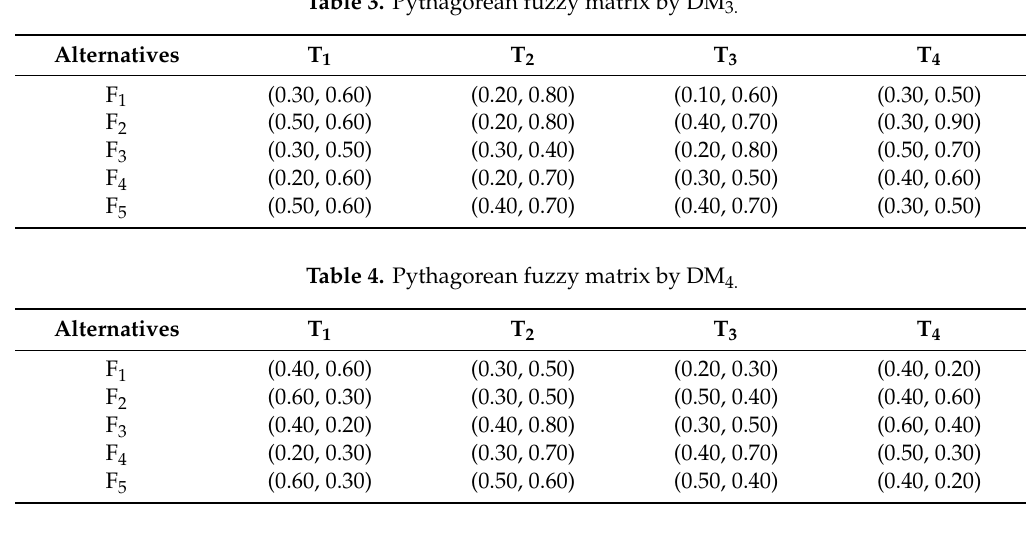
Table 5. Pythagorean fuzzy matrix by DM